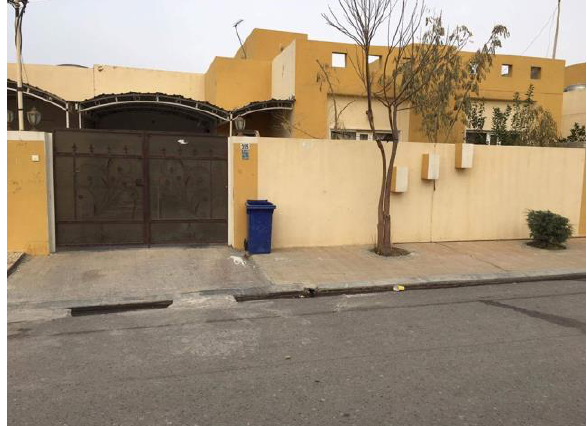
Figure 10. The frontage garden (green area) in the houses at Aarshum project. (By Author)